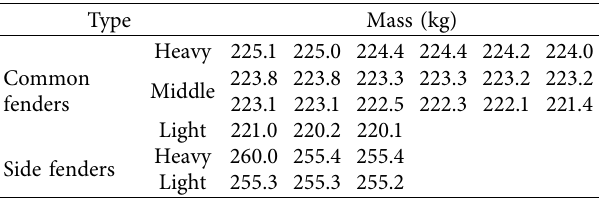
Table 2: Mass of fenders.